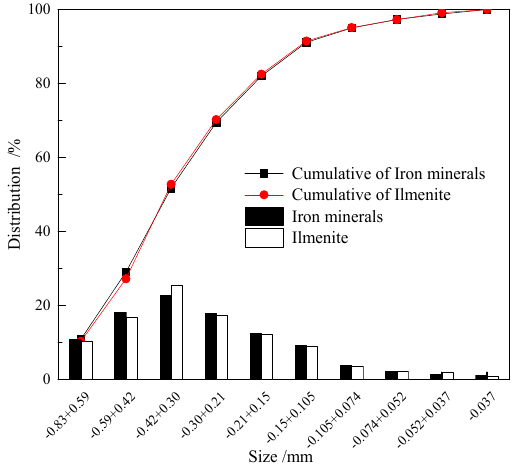
Figure 3. Grain size distribution of metallic minerals in raw sample.